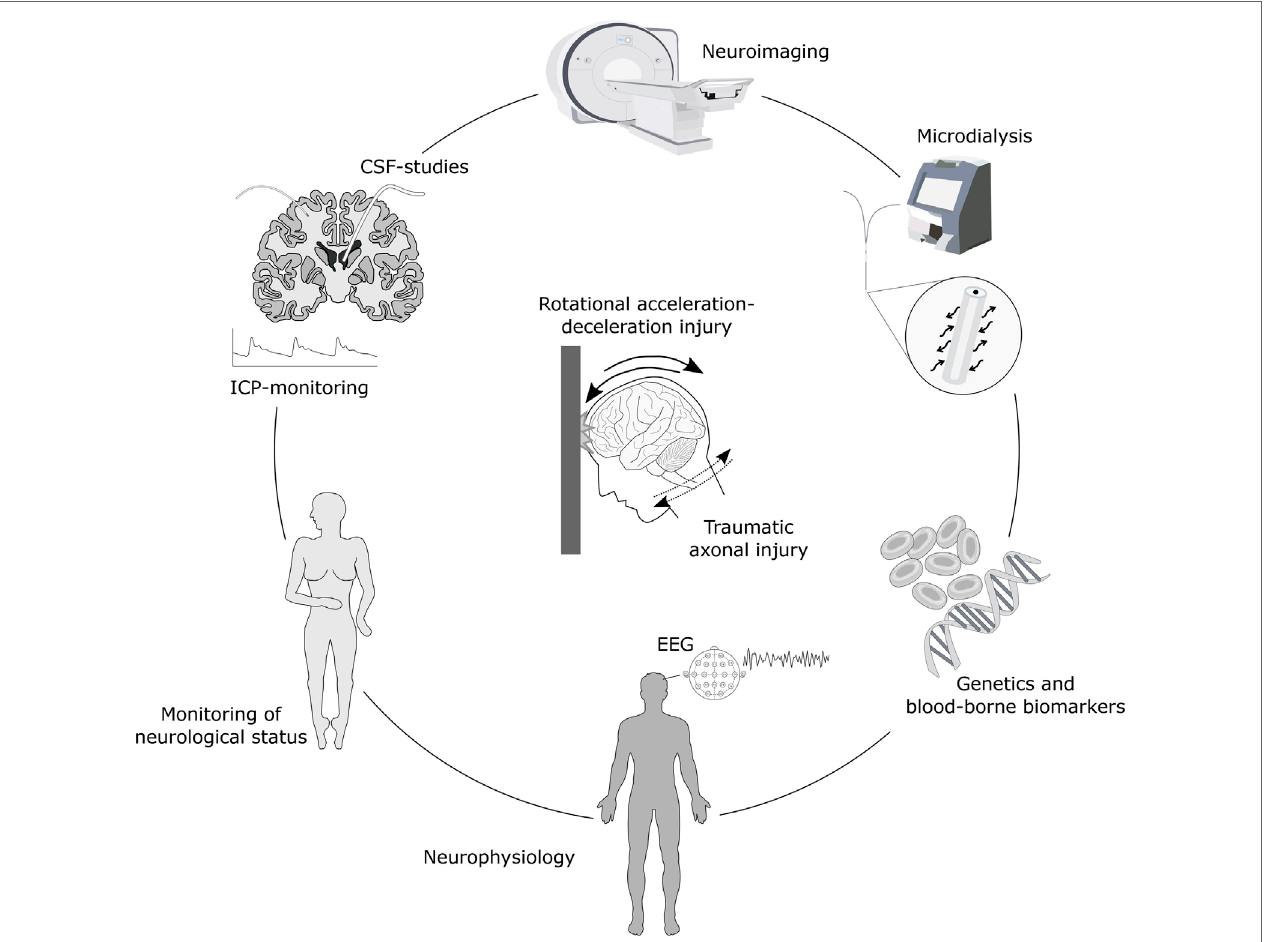
FiGURe 1 | Schematic illustration of monitoring options for axonal injury. Biomechanically, traumatic axonal injury results from head impact with rotational acceleration-deceleration forces. Detection and monitoring of axonal injury is possible with numerous advanced neuroimaging techniques such as magnetic resonance imaging (MRI), including diffusion tensor imaging (DTI) and magnetic resonance spectrometry (MRS), as well as neuromolecular imaging by single-photon emission computed tomography (SPECT) and/or positron emission tomography (PET). Axonal injury also results in the secretion of various biomarkers into the interstitial fluid (ISF), cerebrospinal fluid (CSF) and the bloodstream which can be detected in ISF using microdialysis, in CSF by sampling through an external ventricular drainage or through lumbar puncture, and in serum by blood sampling. These biomarkers provide clues of temporal patterns of axonal injury and ongoing secondary injury processes and may be associated with outcome. Monitoring of axonal injury progression may also be achieved by placement of an intracranial pressure (ICP) monitoring device for continuous surveillance of ICP, neurophysiological methods such as electroencephalography (EEG) and periodic assessments of neurological status including level of consciousness. Furthermore, the genetic profile may add additional information of risk for secondary injury cascades and neurodegenerative